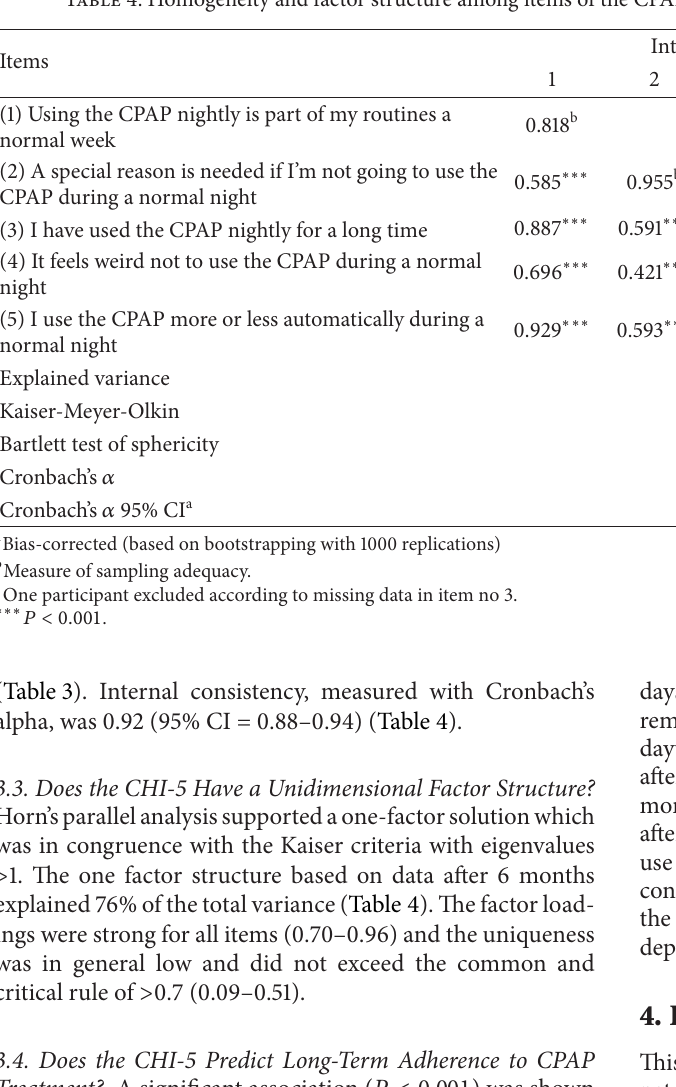
Table 4: Homogeneity and factor structure among items of the CPAP Habit Index-5 after 6 months of CPAP use ( 𝑛 = 116 ) 1 . Items